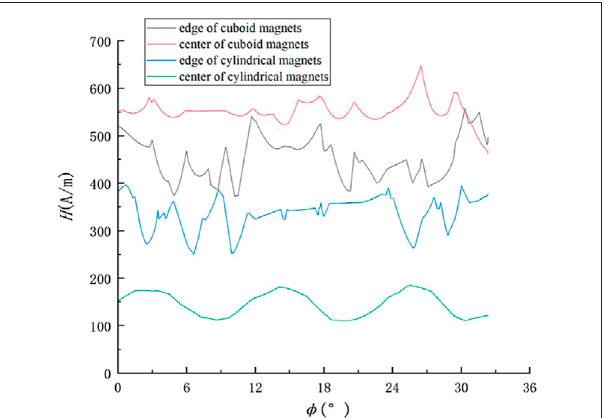
FIGURE 9 | Magnetic fi eld strength curve of the seal gap of different structures of the magnetic fl uid seal.